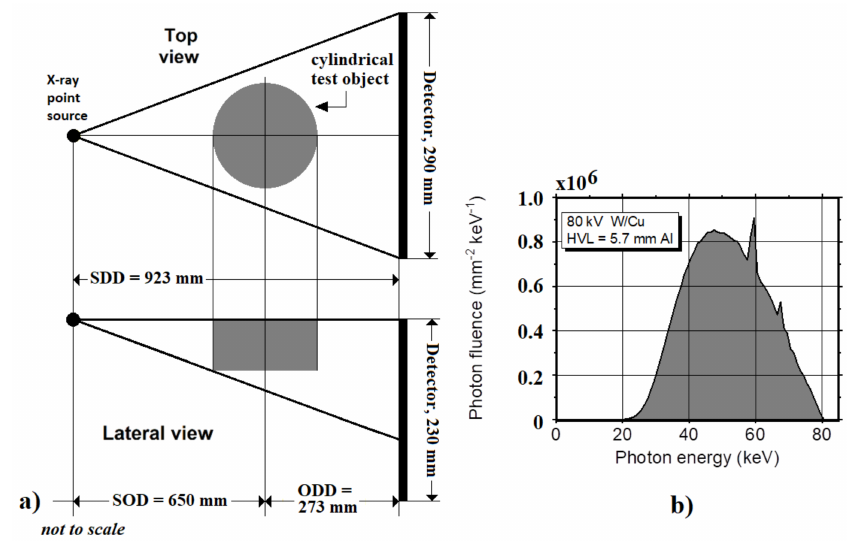
Figure 2. ( a ) The top and lateral views of the simulated CT setup. The X-ray source was at 273 mm (ODD) from the axis of rotation and at 650 mm (SOD) from the 290 × 230 mm 2 flat panel detector. ( b ) The 80 kV W/Cu (HVL 5.74 mm Al) X-ray spectrum was obtained using TASMIP code [36] and used in this test.